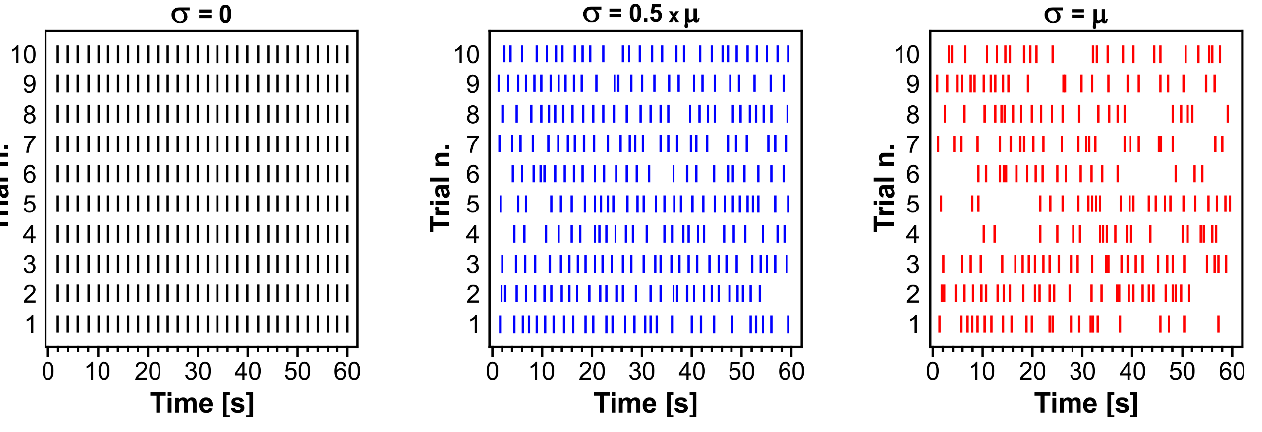
Figure 7. The higher efficiency of lognormal stimulation vs. periodic pacing resides in the degree of pulse sparseness. Computer-generated sequences of 60 s-pulse trains drawn from lognormal distributions with µ = ln(2) and increasing σ values (0, 0.5 × µ and µ ), 10 trials each; at σ = 0, the resulting pulse trains are periodic (constant inter-pulse interval). At increasing σ values, the number of pulses becomes smaller due to the increased inter-pulse interval variability ( σ ), spanning an increasingly wide interval range.